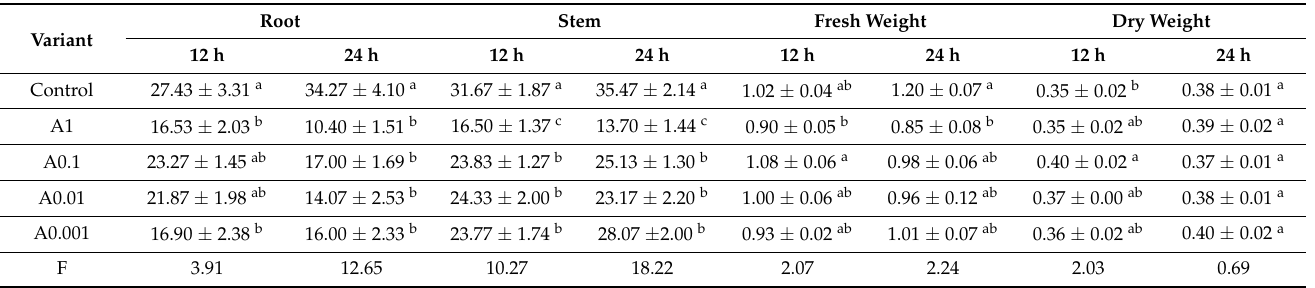
Table 2. Influence of Actellic 50 EC on Triticum aestivum seedling growth.